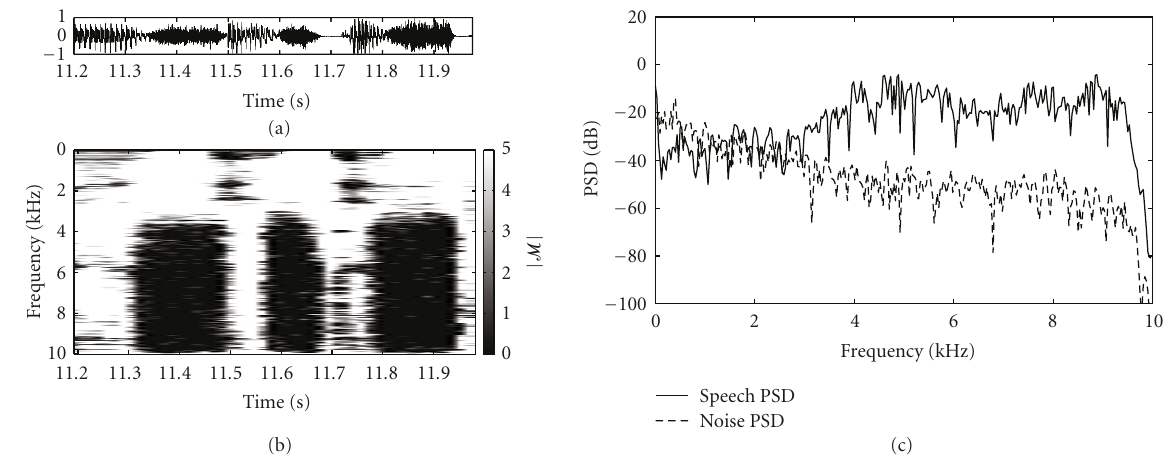
Figure 8: (a) Clean speech signal with the text ..since this story hap .... (b) The number of noise-only bins per band. (c) PSD of clean speech and noise signal during the time interval 11.85–11.88 seconds.